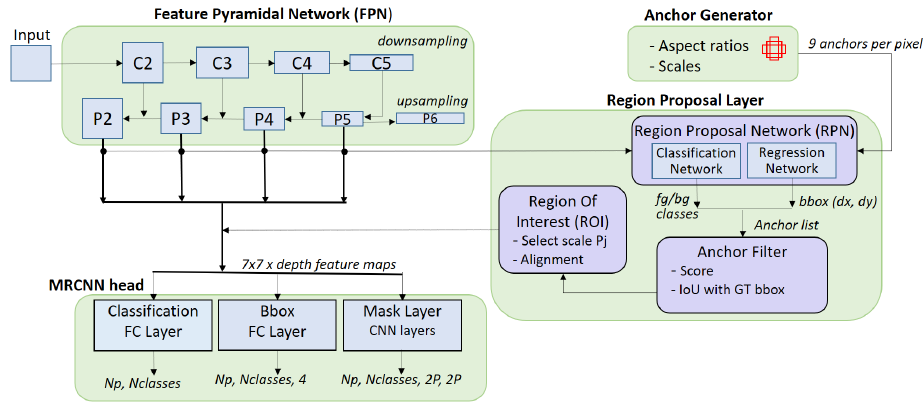
Figure 2. The Mask-RCNN